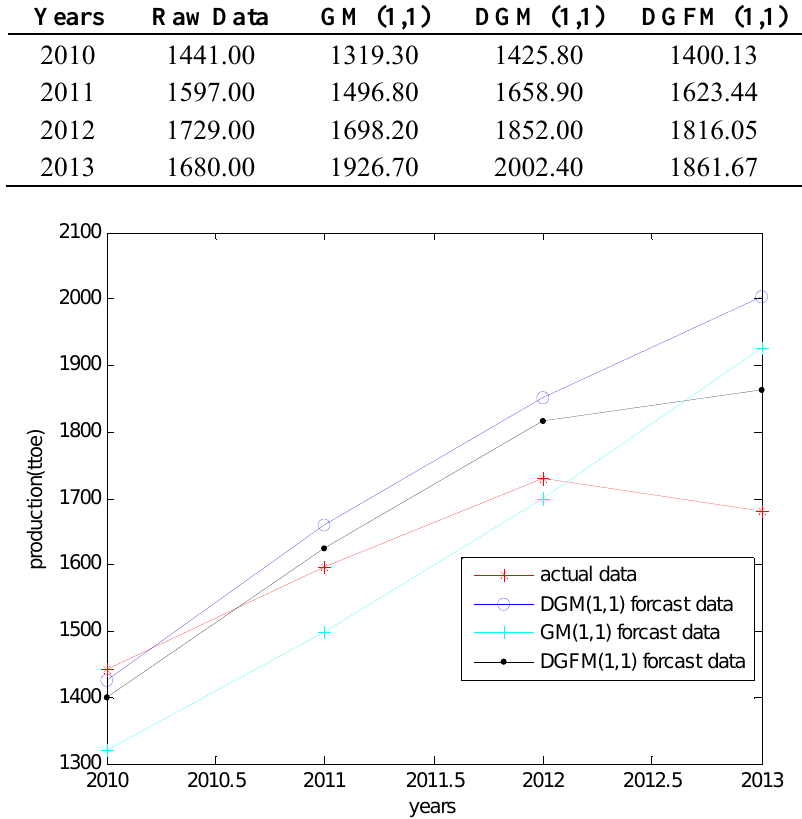
Table 9. Comparison of the three models with the actual data.